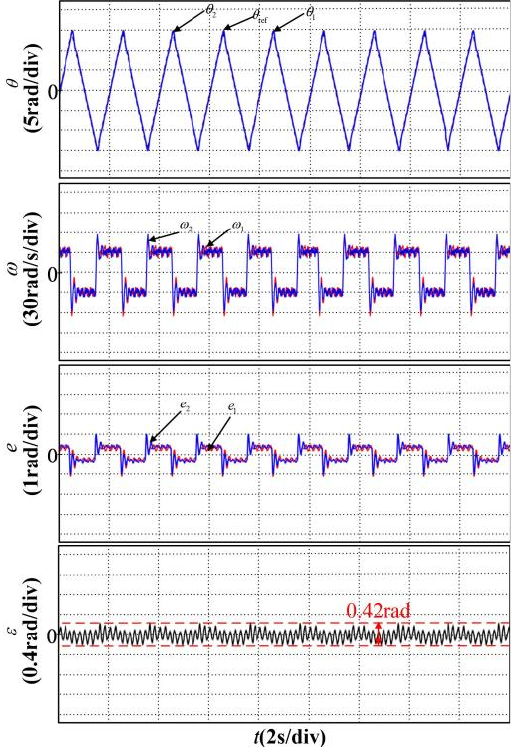
Figure 15. Motor responses when L changes.